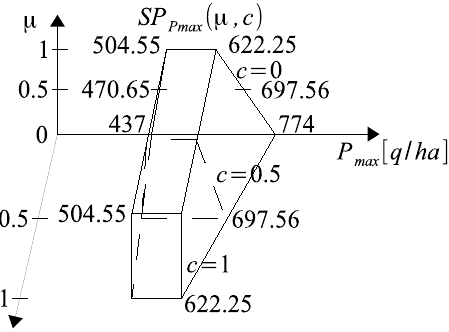
Figure 38. Span function SP P max ( µ , c ) of the uncertain yield P max of SB [ q/ha ] that may occur in the field under consideration after optimal nitrogen fertilization. The uncertainty of the yield is caused by natural factors independent of the grower.